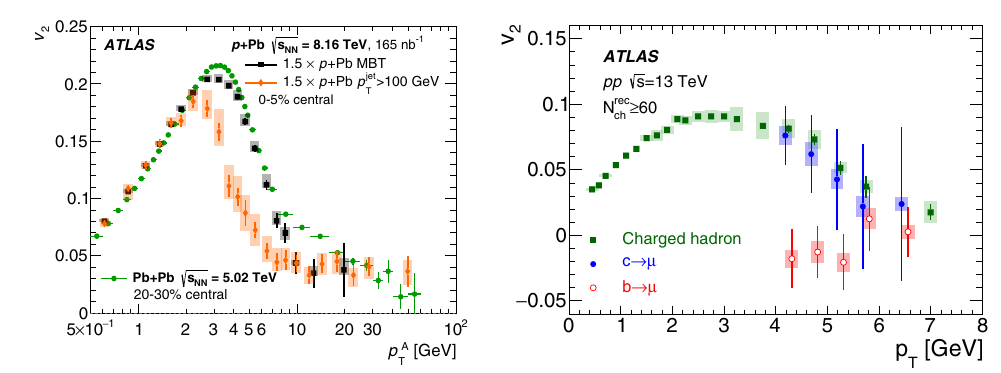
Figure 2. Left: Measured azimuthal anisotropy coe ffi cients v 2 in p + Pb collisions using 8.16 TeV data, from Figure 1. Left: Demonstration of hydrodynamic expansion of QGP medium in small collision systems, as part Ref. [10]. Right: Measured v 2 for muons from charm and bottom hadron decays, compared to that for light of the RHIC “projectile scan,” from Ref. [4]. Right: Calculated v 2 , 3 , 4 values in central p + Pb collisions at low and hadrons, in high-multiplicity 13 TeV pp collisions, from Ref. high p T , from Ref. [5].